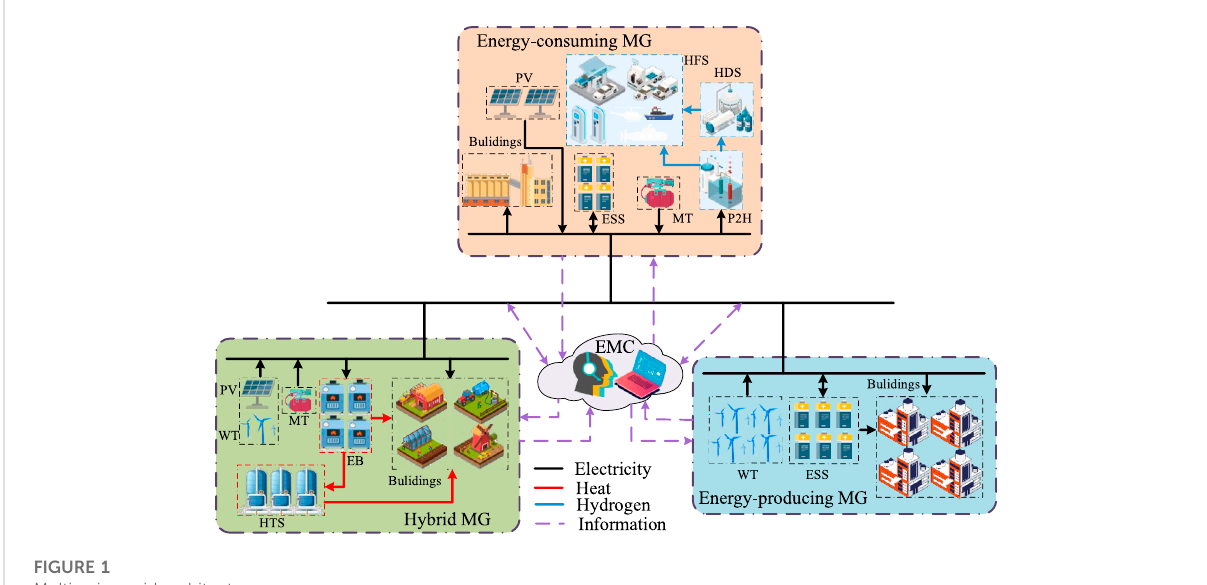
FIGURE 1 Multi-microgrid